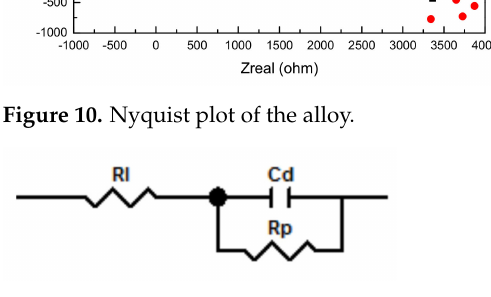
Figure 11. The equivalent fitting circuit.